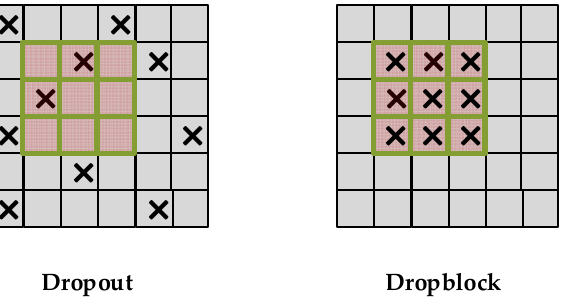
Figure 4. The difference between a standard neural network model and a neural network using Dropout (The red solid circle represents the dropped-out neurons).